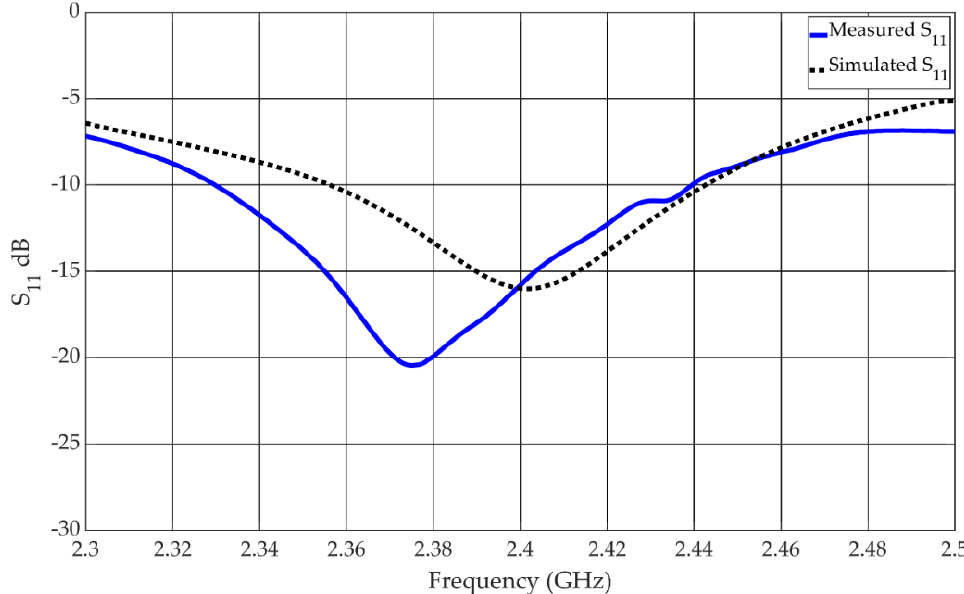
Figure 6. Measured and simulated reflection coefficient of the antenna in the linear state.